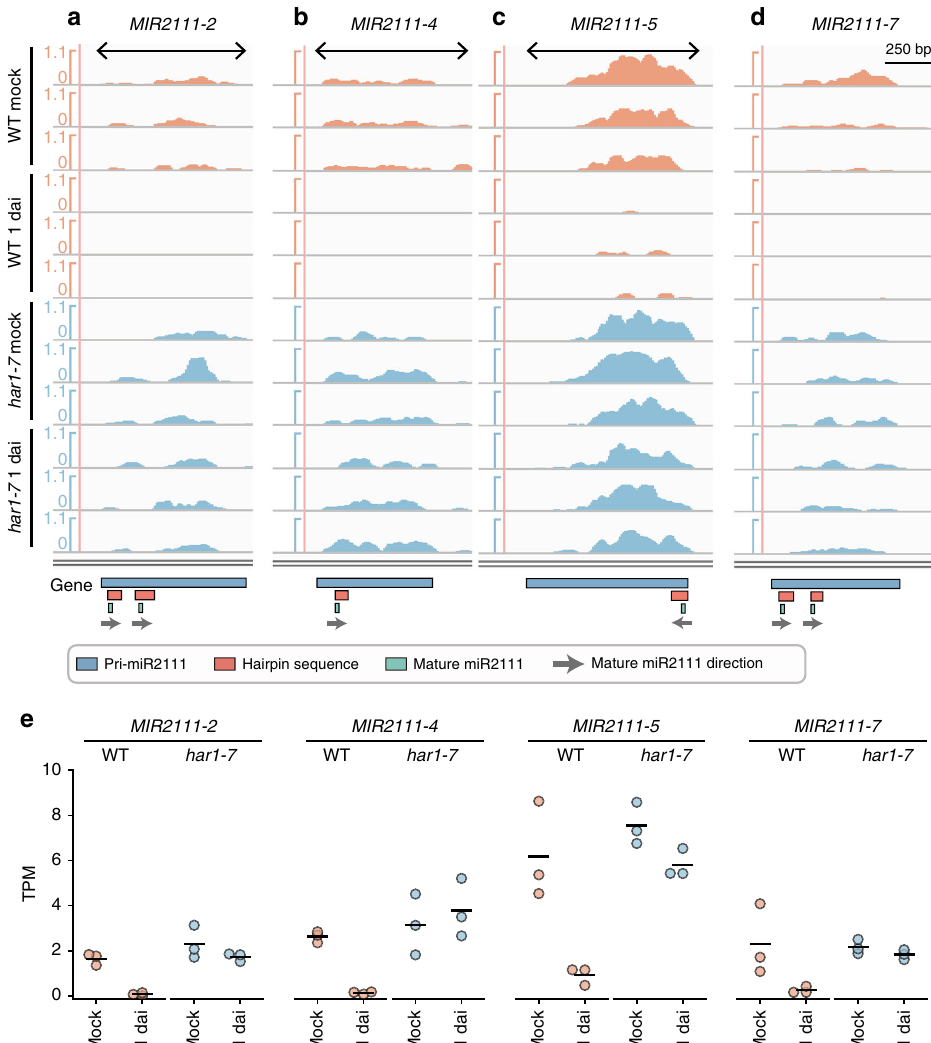
Fig. 1 Expression of four L. japonicus miR2111 genes, including those identi fi ed by RNA-seq analysis. a – d RNA-seq read coverage of MIR2111-2 ( a ), MIR2111-4 ( b ), MIR2111-5 ( c ), and MIR2111-7 ( d ) were visualized by the Integrative Genomics Viewer. All data were acquired by RNA-seq of mature leaves of wild-type (MG-20) and har1-7 plants that were inoculated with M. loti (1 day after inoculation) or mock-treated (control). RNA-seq libraries were prepared using poly(A) enrichment method, and miR2111 genes were predicted by RNA-Seq-based gene prediction using Stringtie version 1.3.4d with default settings. Read abundance normalized in bins per million (BPM) is shown. Gray arrows in the gene column represent the directions of mature miR2111 ( Bottom ). Regions used for the over-expression assay are indicated as black two-directional arrows ( Top ) (see Fig. 2). e Transcripts per million (TPM) values of four miR2111 genes. Scatterplots show individual biological replicates as dots. Bars indicate mean